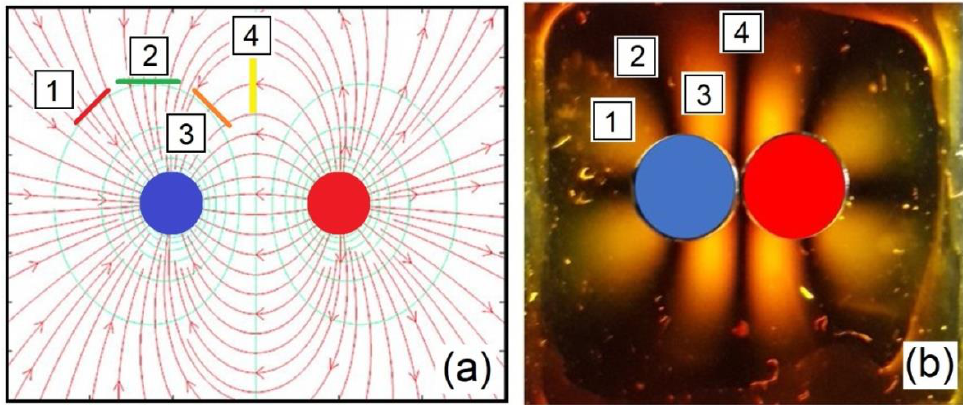
Figure 3. Diagram of the field lines of a magnetic dipole with linear polarization orientation at some points in ( a ), showing that the polarization of light is perpendicular to the field lines. ( b ) Image of the light pattern of a magnetic dipole for the ferrofluid sample placed between two crossed linear polarizers. In the figures, each number represents a type of linear polarization of light, as follows: (1) 45 degrees positive polarization (red), (2) horizontal polarization (green), (3) negative 45 degrees polarization (orange), (4) vertical polarization (yellow).